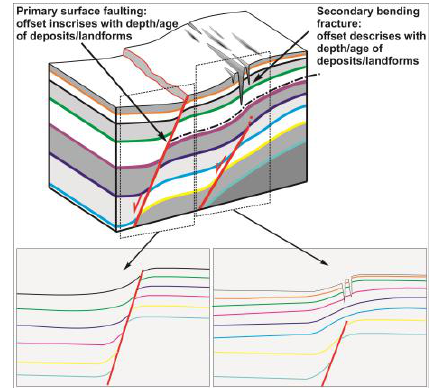
Figure 1. Structural scheme of the different displace- ment features related to primary surface faulting and secondary (extrados)